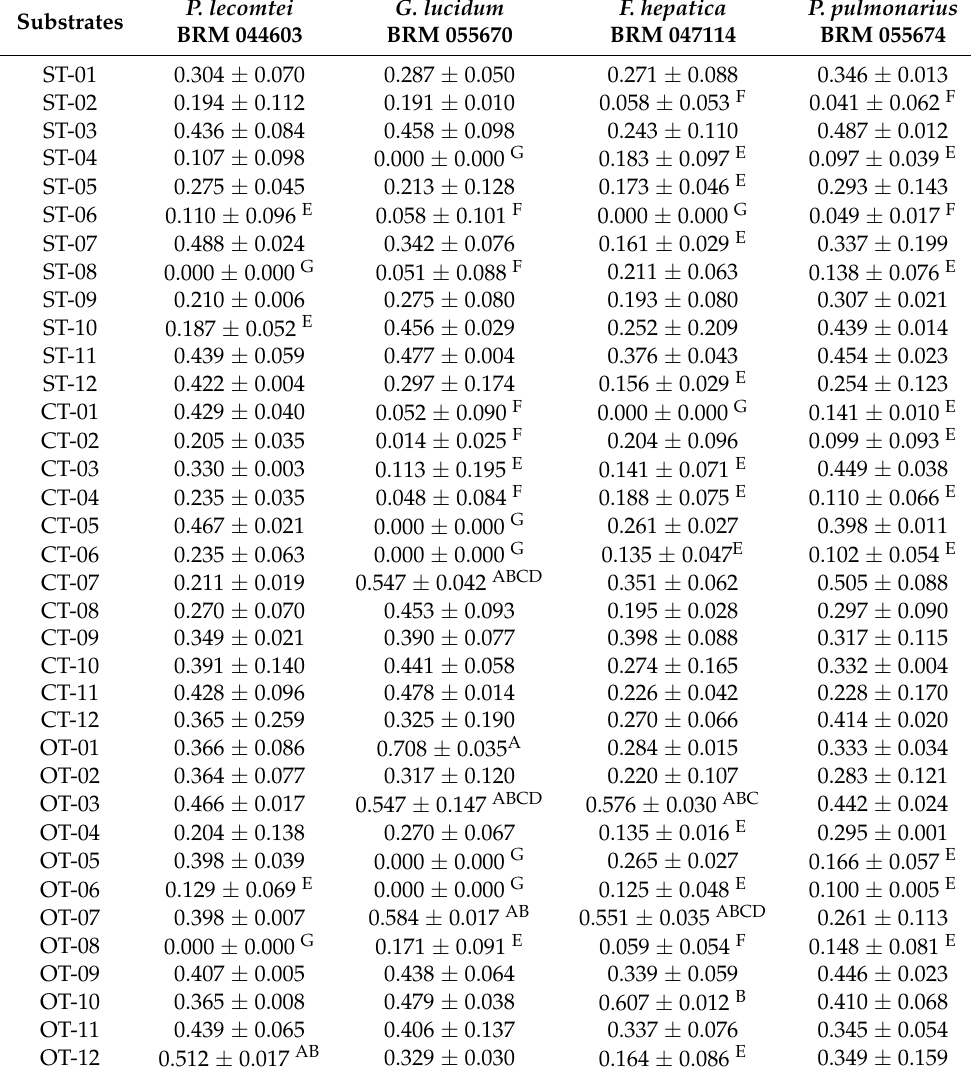
Table 3. Mycelial growth rate of filamentous fungi in substrates commonly used as animal feed biomass. The experiment was performed in triplicate and values shown are the mean in cm/day ± standard